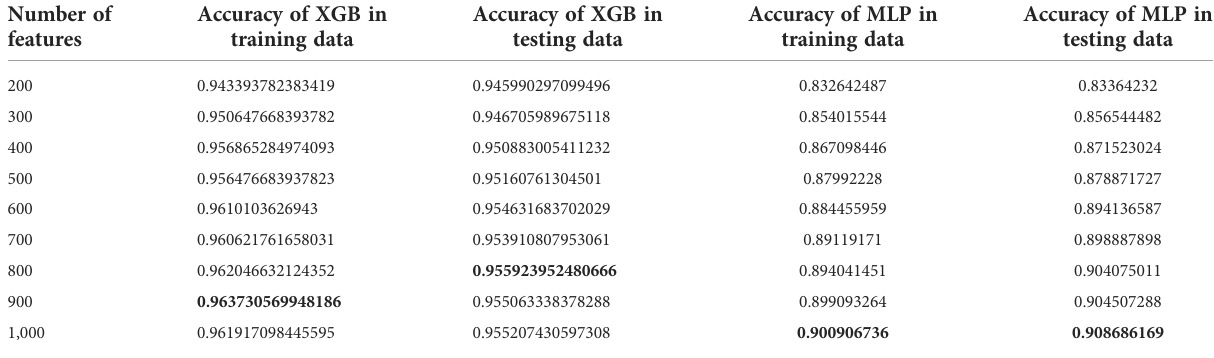
TABLE 2 The accuracy of training data and testing